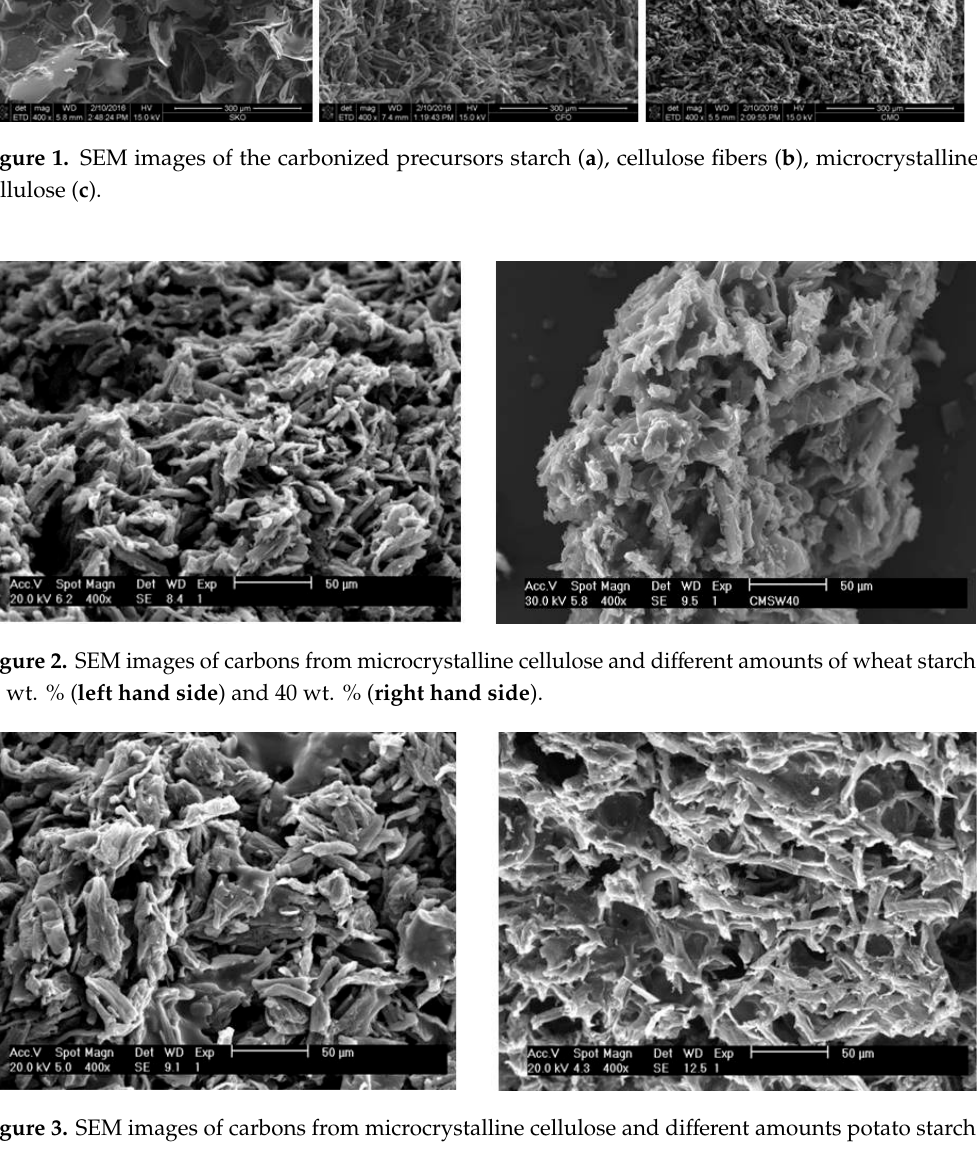
Figure 1. SEM images of the carbonized precursors starch ( a ), cellulose fibers ( b ), microcrystalline cellulose ( c ).